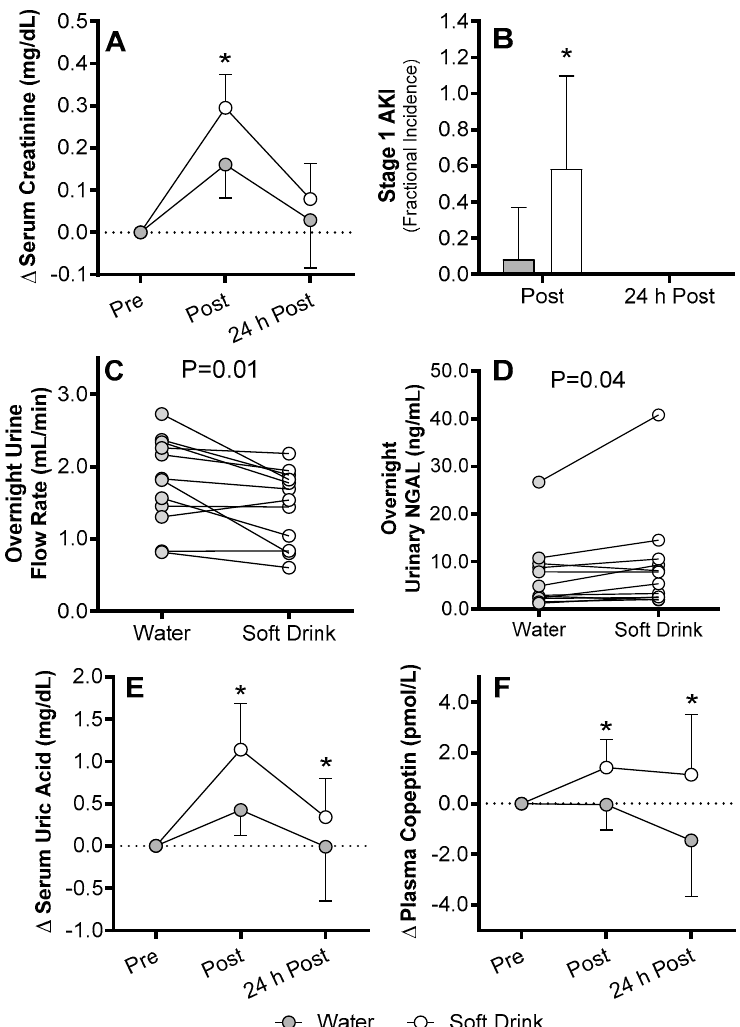
Figure 4. Despite no differences in core temperature or changes in body weight (data not shown), drinking a high fructose soft drink compared to water during and following 4 h of exercise in the heat resulted in greater changes ( Δ ) in serum creatinine ( A ), meeting the criteria for Stage 1 acute kidney injury (AKI) at Post exercise in ~60% of the subjects ( B ). During the overnight period (defined as the time from leaving the laboratory immediately after post-exercise data collection until returning to the laboratory 24 h following pre-exercise (~18 h following post-exercise)), drinking a soft drink reduced urine flow rate (despite drinking ~347 mL more fluid during the overnight period) ( C ) and elevated urinary neutrophil gelatinase-associated lipocalin (NGAL) ( D ). These changes in indices in kidney function and biomarkers of AKI in the soft drink trial were paralleled by greater elevations in serum uric acid ( E ) and plasma copeptin ( F) , a stable surrogate for vasopressin. * different from Water ( p < 0.05), Mean ± SD or individual values, n = 12. From Chapman et al. [30] with permission.